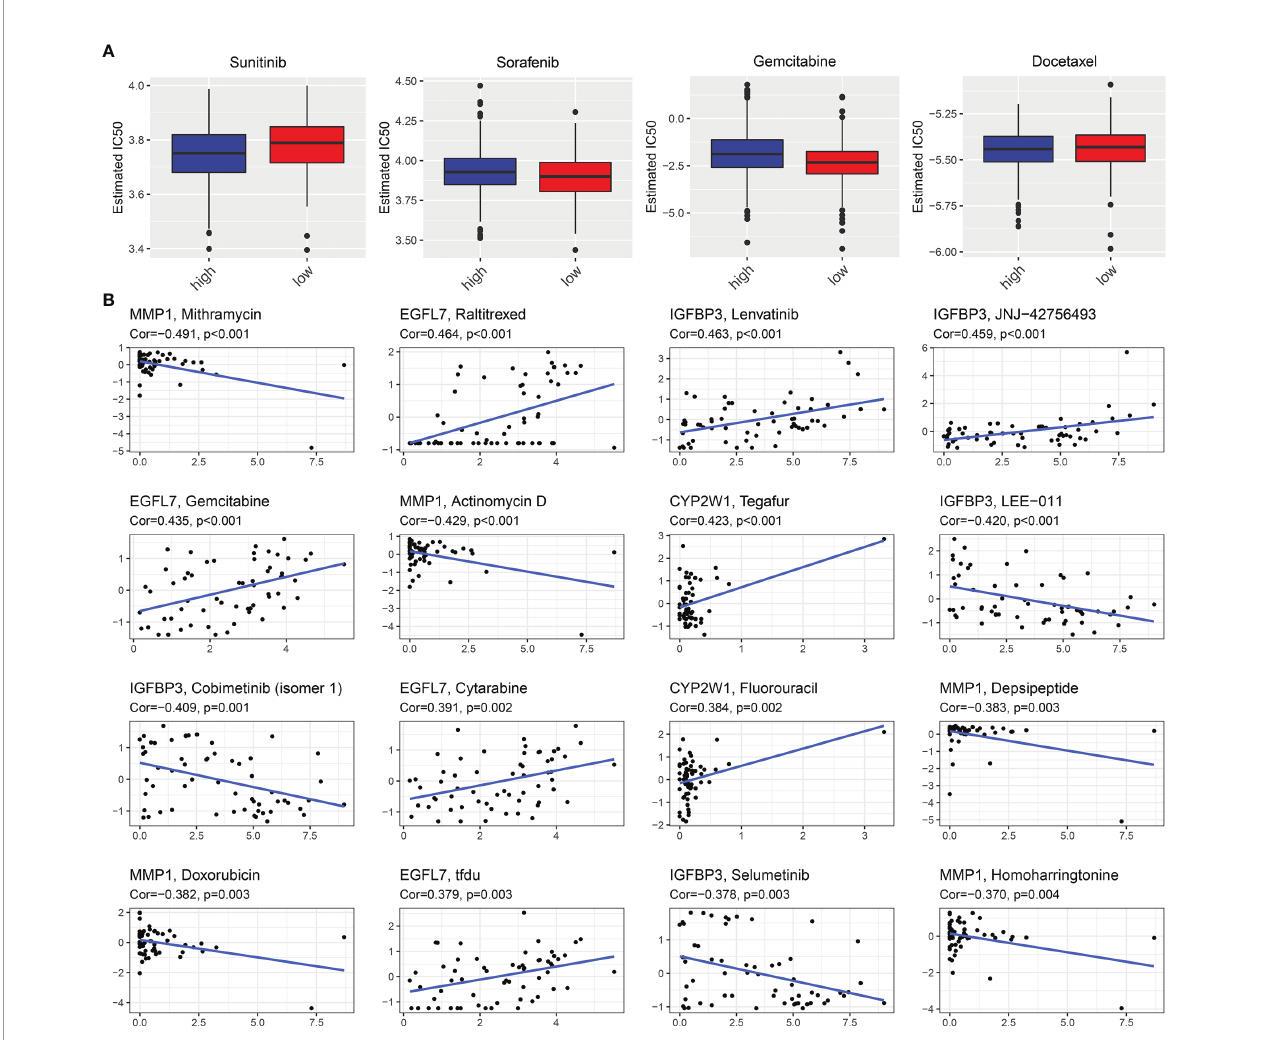
FIGURE 8 | EVA1B-derived genomic model predicts drug responses of CRC patients. (A) Comparison of the estimated IC50 values of sunitinib, sorafenib, gemcitabine, and docetaxel between high- and low-risk CRC subpopulations. (B) Associations of EVA1B-relevant genes with IC50 values of small molecule compounds in